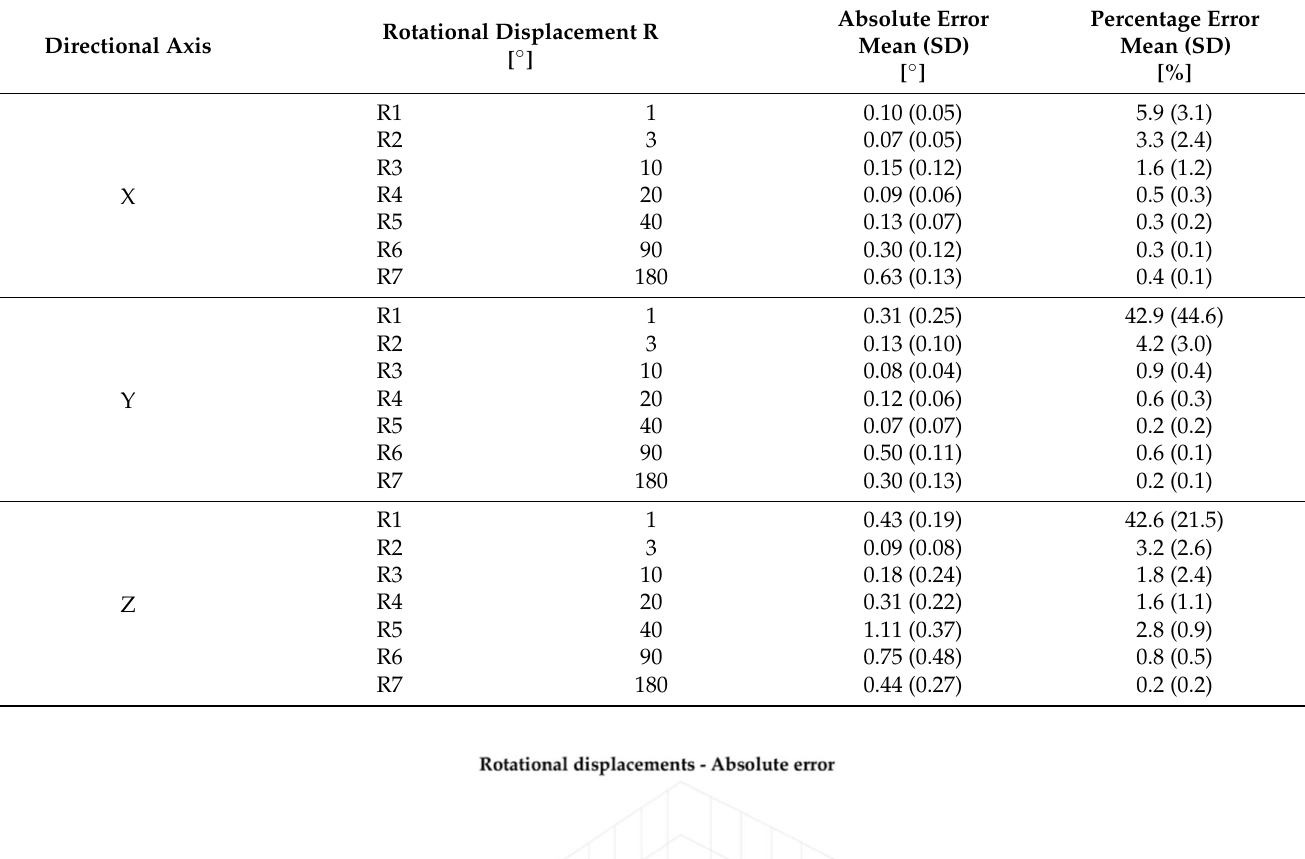
Table 3. Errors for all the rotational displacements around the x-, y-, and z-axes.